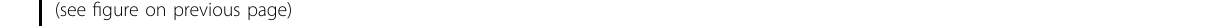
Fig. 2 The temporal expression and function of ATF3 in the endometrium. A , B Immunohistochemistry analysis with an anti-ATF3 antibody. Proliferative and mid-secretory phase endometrial tissue samples from normal fertile women. The negative control (NC) was nonspeci fi c rabbit serum. The H -score of ATF3 expression in the endometrial stromal cells was calculated with IHC-Pro fi ler and ImageJ (Scale bar = 50 µm, n = 3, * P < 0.05). C Expression of ATF3 in proliferative and early-, mid-, and late-luteal phase endometrium. Each bar represents an individual biopsy. The data were retrieved from microarray data deposited in the Gene Expression Omnibus (GDS2052). D , E ATF3 expression pattern analyzed with a recent single-cell RNA-seq analysis in stromal cells ( D ) and all cells ( E ). The data were retrieved from microarray data deposited in the Gene Expression Omnibus (GSE111976). F The expression pattern of ATF3 in hESCs treated with 0.5 mM 8-Br-cAMP and 1 μ M MPA (M + A) for different periods of time (0, 0.5, 1, 2, 4, 8, or 16 h) was evaluated by qPCR. * P < 0.05, ** P < 0.01. G The expression pattern of ATF3 in hESCs treated with 0.5 mM 8-Br-cAMP and 1 μ M MPA (M + A) for different periods of time (0, 1, 3, 6, 12, 24, 48, or 72 h) was evaluated by western blot. H GSEA results showed that the ATF3- regulated gene term was enriched during in vitro decidualization. I , J hESCs were transfected with siATF3 or siCtl for 48 h and then treated with a decidualization stimulus. The expression and secretion of PRL were measured by qPCR and ELISA, respectively. * P < 0.05, ** P < 0.01 compared with the CTL/M + A group (8-Br-cAMP + MPA). K Immuno fl uorescence was performed to analyze the morphological transformation of hESCs.